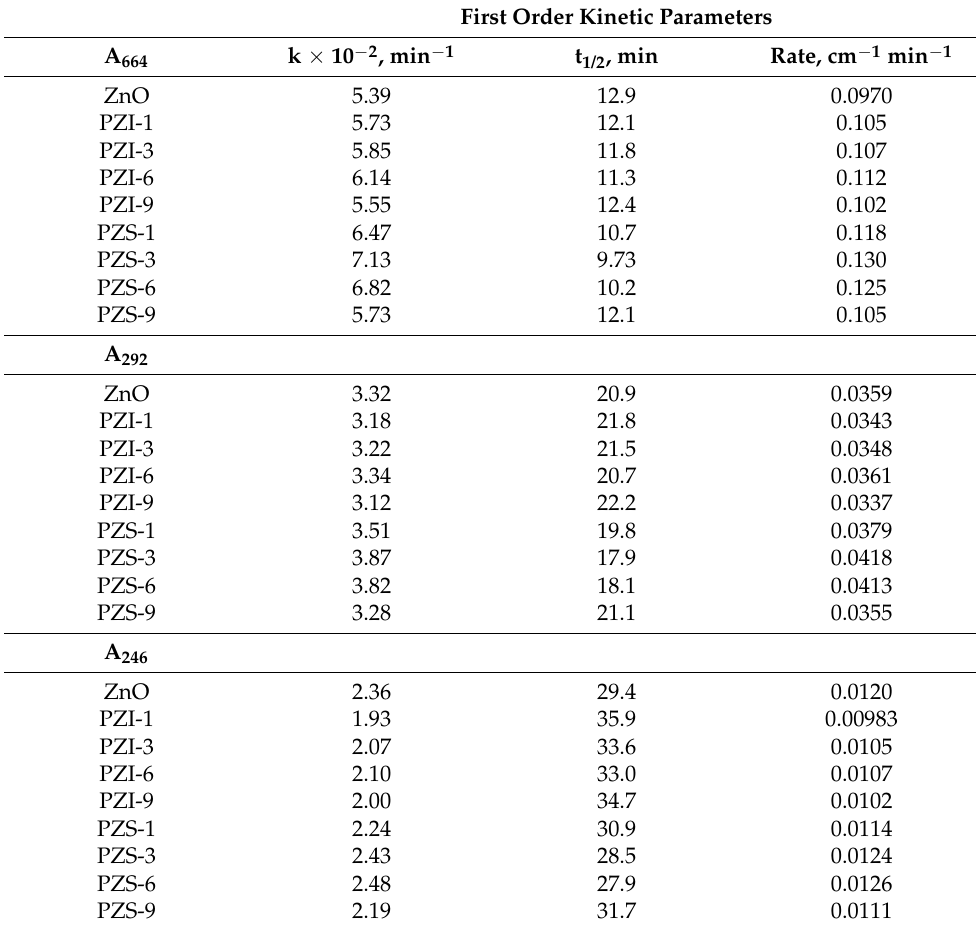
Table 1. Photocatalytic degradation kinetics of MB expressed by A 664 , A 292 and A 246. First Order Kinetic